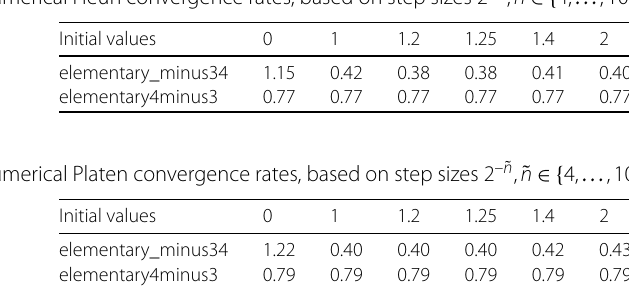
Table 4 Numerical Heun convergence rates, based on step sizes 2 – ˜ n , ˜ n ∈ { 4, ... ,10 }